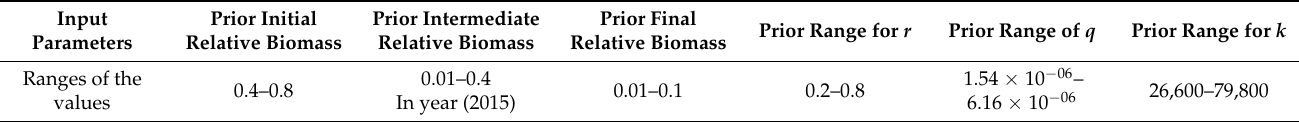
Table 4. Relative biomass, ranges for r , k , q as priors in CMSY+ of L. indicum in BoB. Input